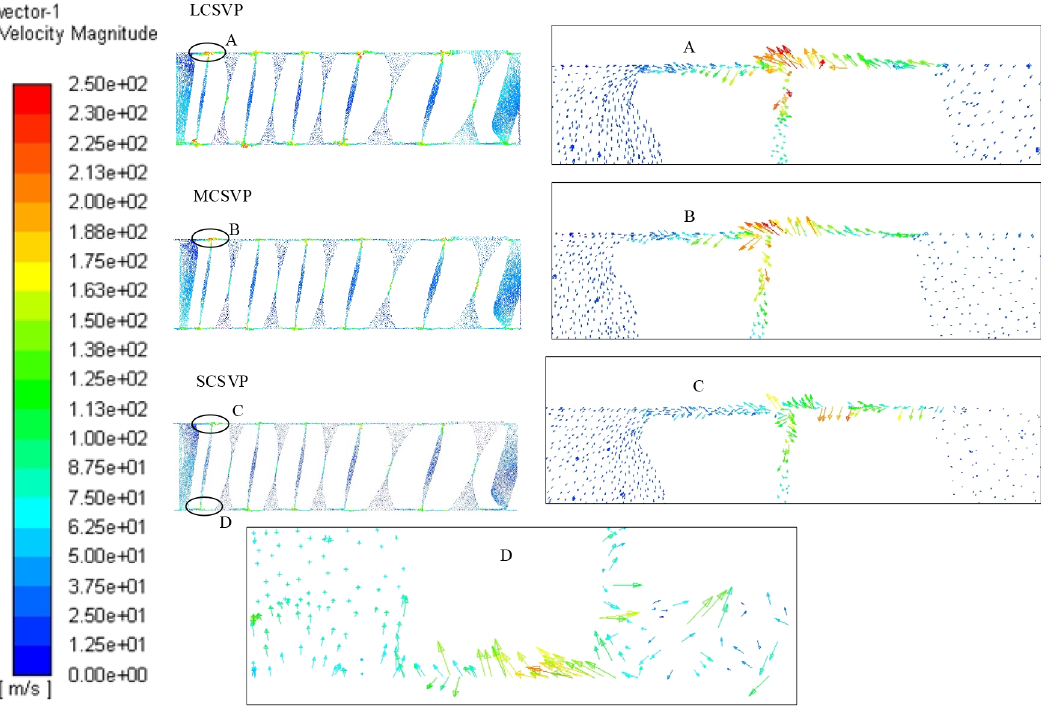
Fig. 12. The fl ow velocity vector diagram of the three